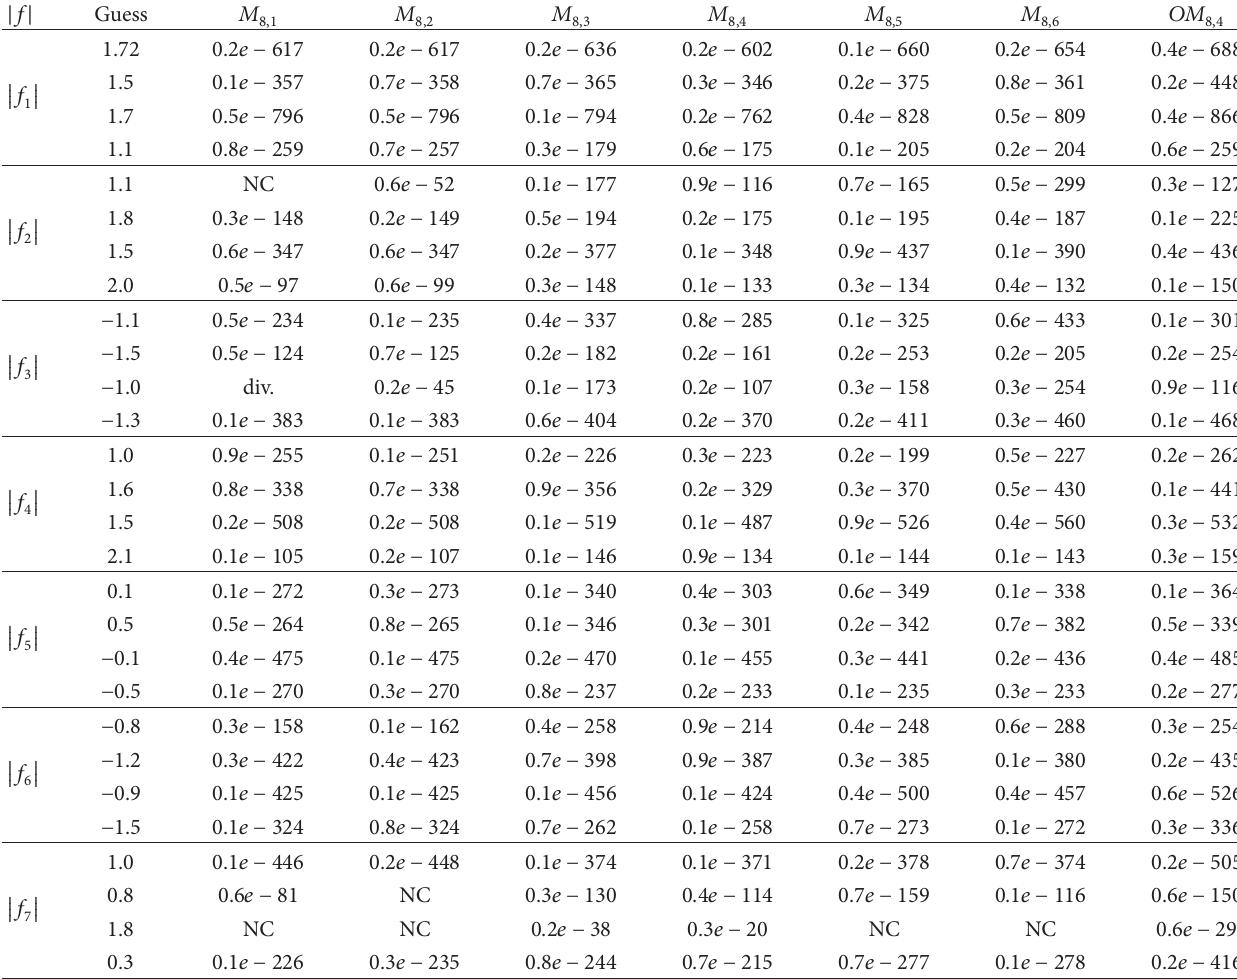
Table 2: Comparison of absolute value of the functions after third